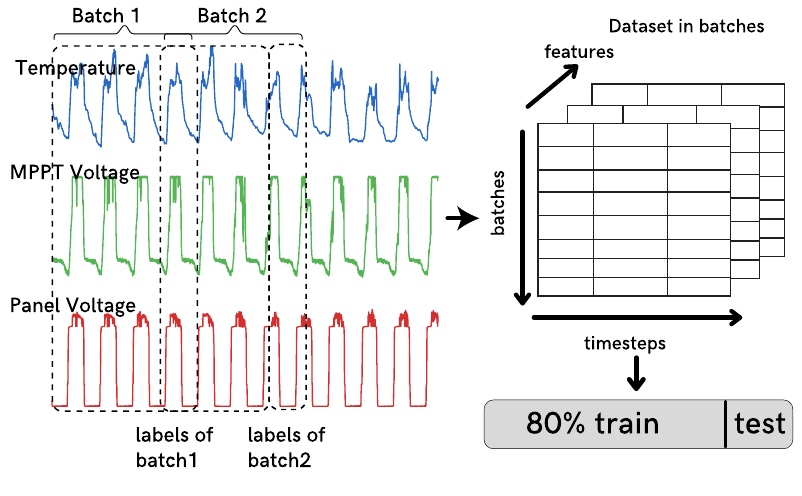
Figure 13. Data preparation